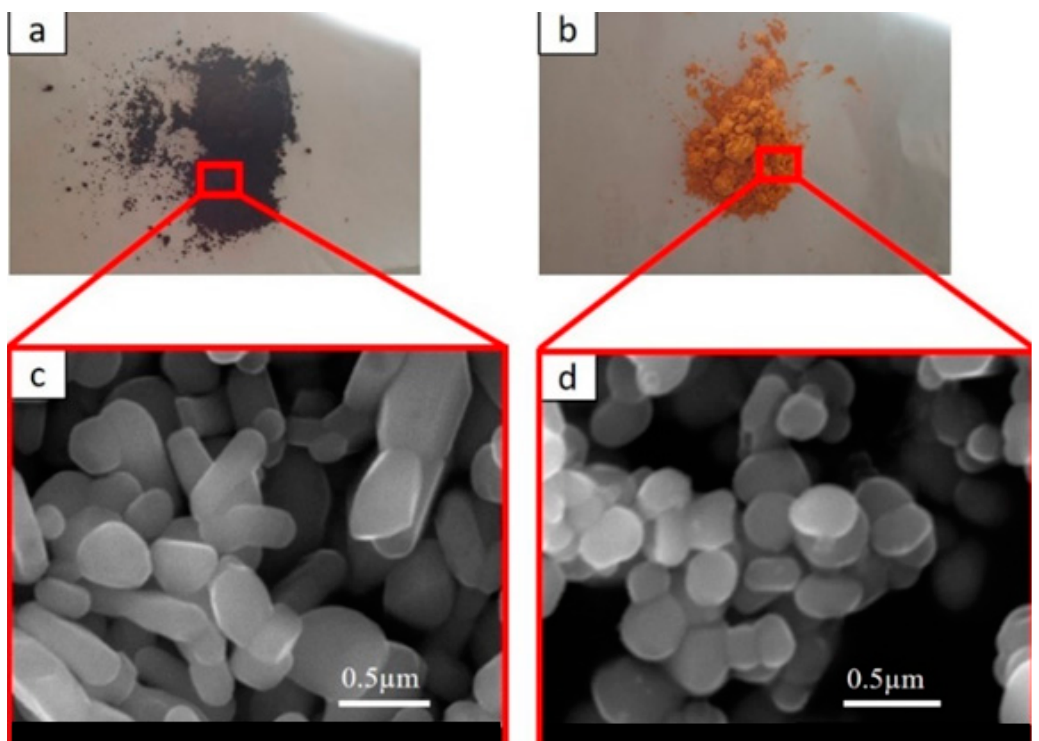
Figure 1. ( a ) Black near-infrared inorganic reflective (NIR)-reflective pigment; ( b ) yellow NIR-reflective pigment. SEM images of ( c ) black NIR-reflective pigment ( d ) yellow NIR-reflective pigment.